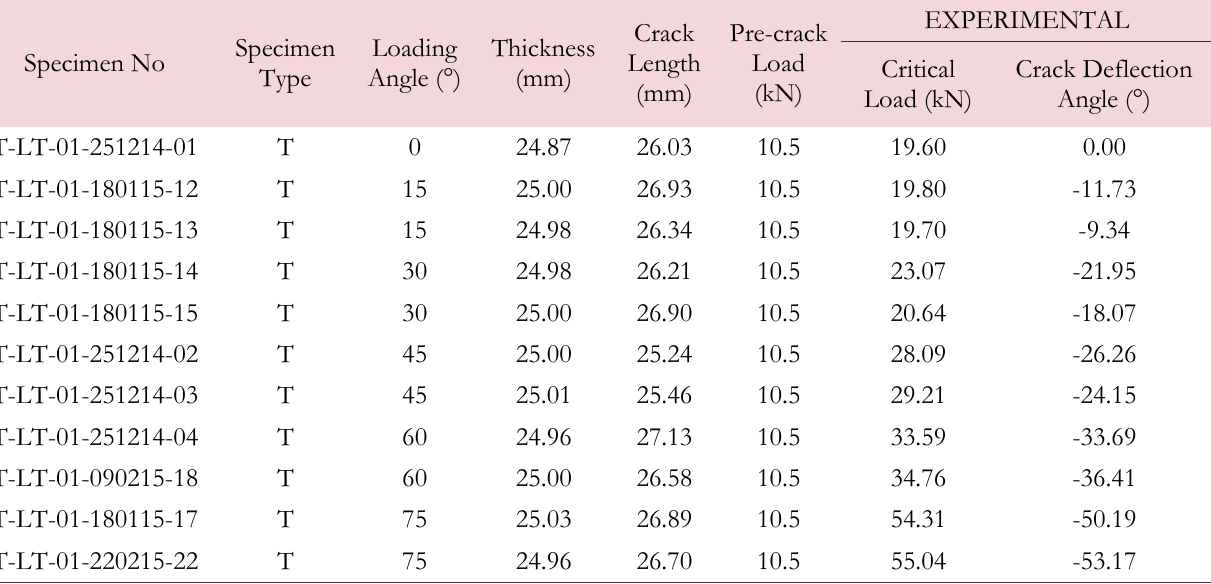
Table 2: Experimental results of T specimen obtained from the mixed mode fracture